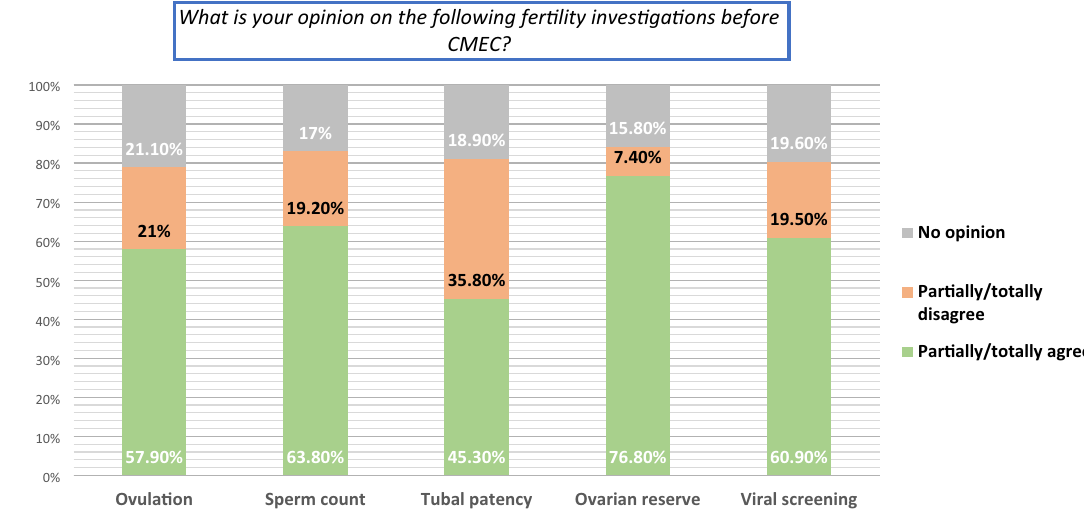
Figure 3. Opinions on fertility-specific investigations upon conservative management of endometrial cancer. CMEC Conservative management of endometrial cancer. Question subset A was delivered to clinicians active in infertility care (N = 103). Response rate > 89% for all items. Ovarian reserve assessed with AMH (Anti-Mullerian Hormone) or AFC (Antral Follicle Count).